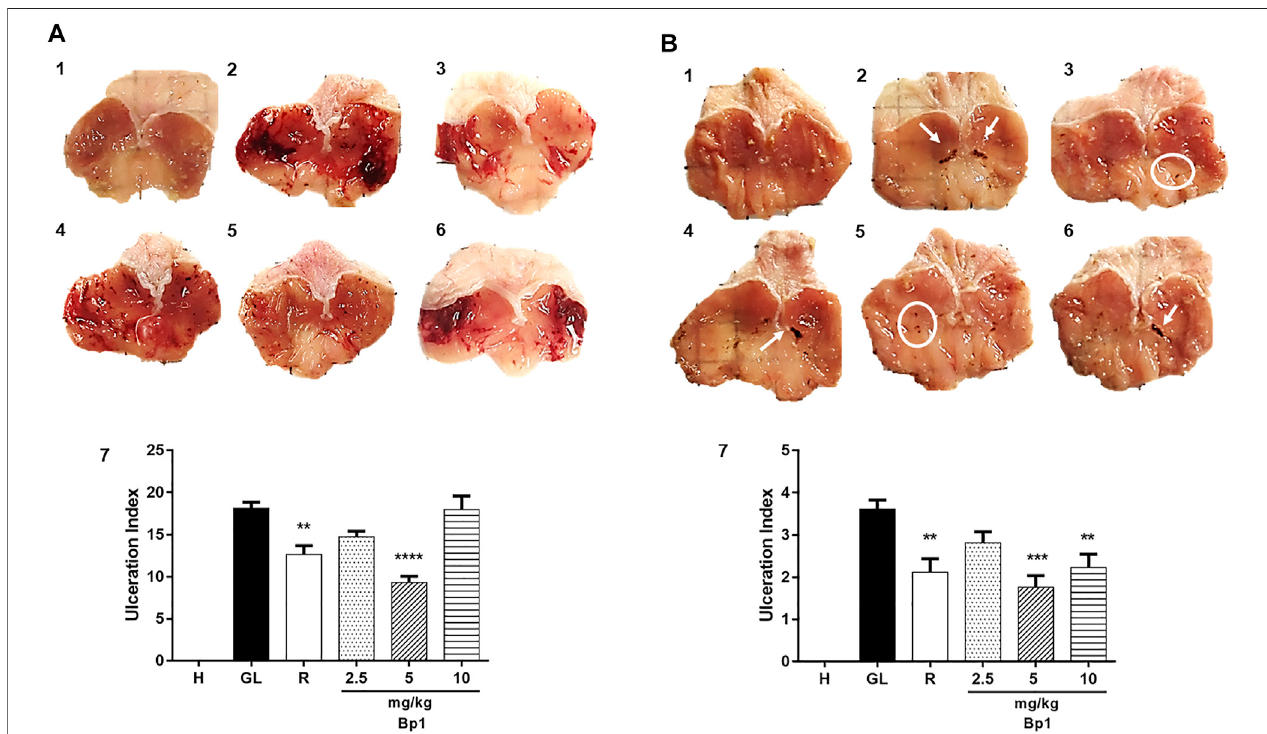
FIGURE 10 | Effect of pretreatment with Bp1 (2.5, 5, and 10 mg/kg) on the macroscopic appearance of the gastric mucosa in ethanol-induced (A) and indomethacin-induced (B) gastric mucosal lesions in mice. (A) Ethanol-induced: 1) healthy; 2) gastric lesion control; 3) ranitidine, 50 mg/kg; 4) Bp1, 2.5 mg/kg; 5) Bp1, 5 mg/kg; 6) Bp1, 10 mg/kg; 7) ulceration index. (B) Indomethacin induced: 1) healthy; 2) gastric lesion control; 3) ranitidine, 50 mg/kg; 4) Bp1, 2.5 mg/kg; 5) Bp1, 5 mg/kg; 6) Bp1, 10 mg/kg; 7) ulceration index. Results are expressed as mean ± standard mean error ( n (cid:2) 7). ANOVA and Dunnett post-test were used